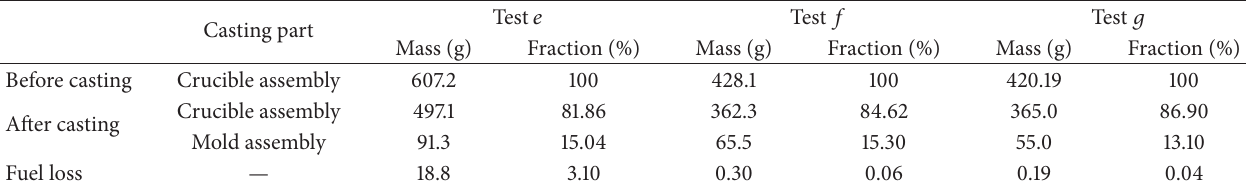
Table 3: Material balance after injection casting of U–10 wt% Zr–5wt% RE fuel